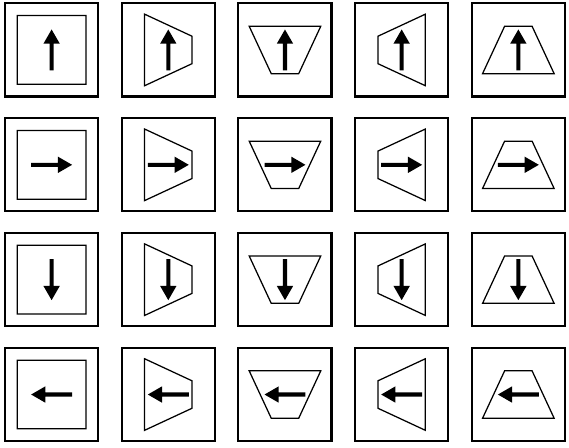
Fig. 2. Position for taking test fields images with a stable geometry